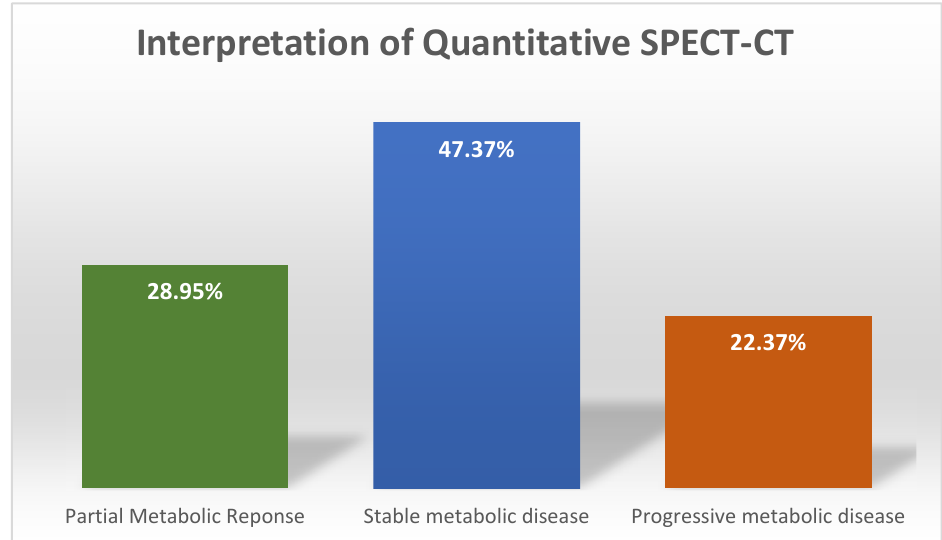
Figure 5. Patient distribution after treatment response evaluation.